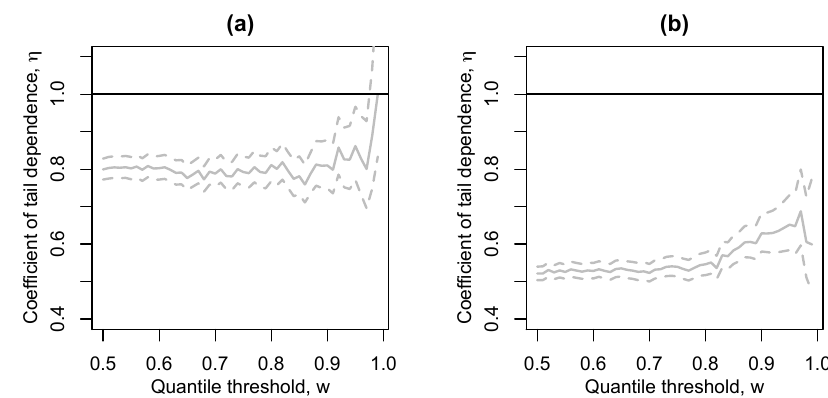
Figure 5. Diagnostic plots of maximum-likelihood estimates (solid) and 95% profile likelihood confidence intervals (dashed) of η , in Eq. (4), for threshold w in the range of the 0.5–1 quantile of T , for London paired with (a) Amsterdam and (b) Madrid.